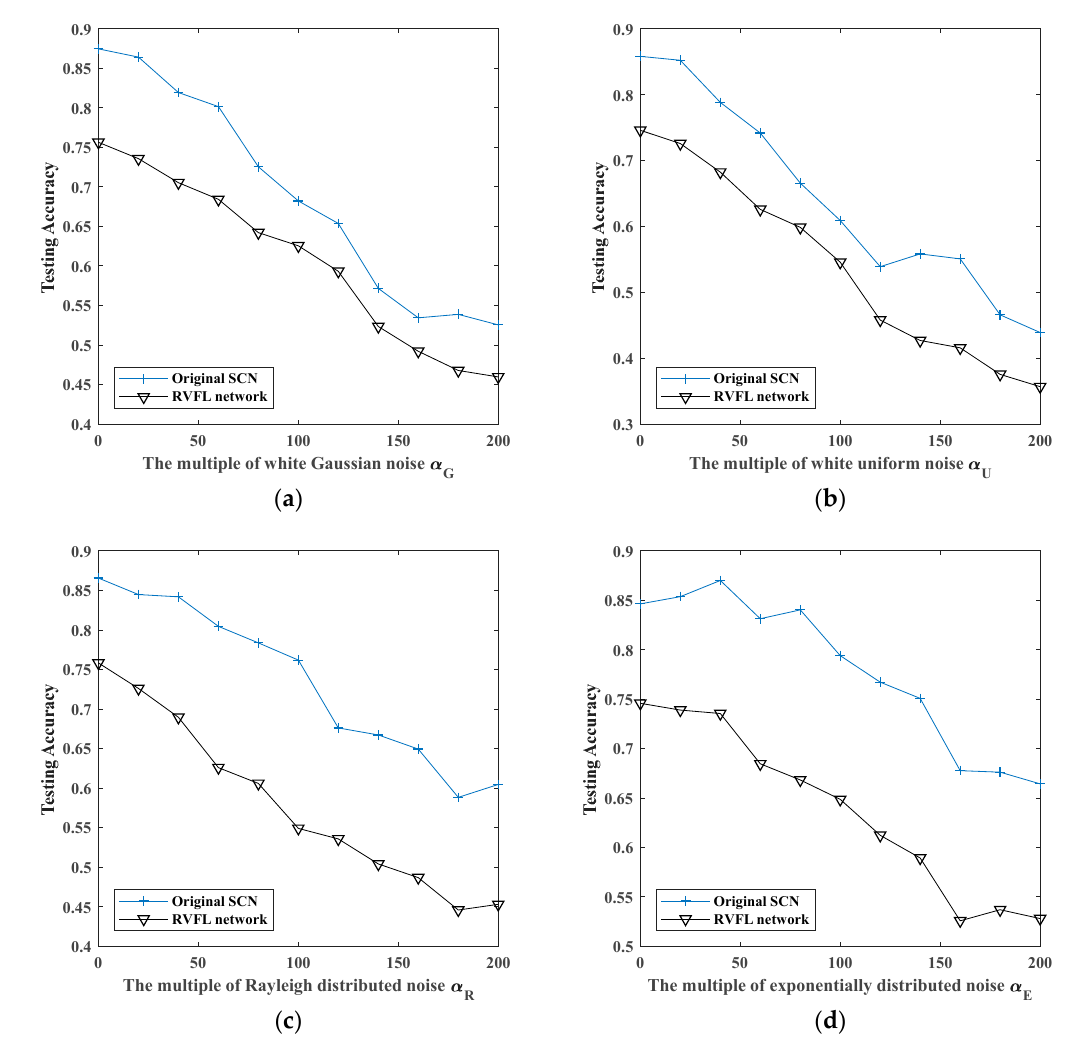
Figure 15. The maximum testing accuracy of original SCN and RVFL network with different noises: ( a ) white Gaussian noise; ( b ) white uniform noise; ( c ) Rayleigh distributed noise; ( d ) exponentially distributed noise.